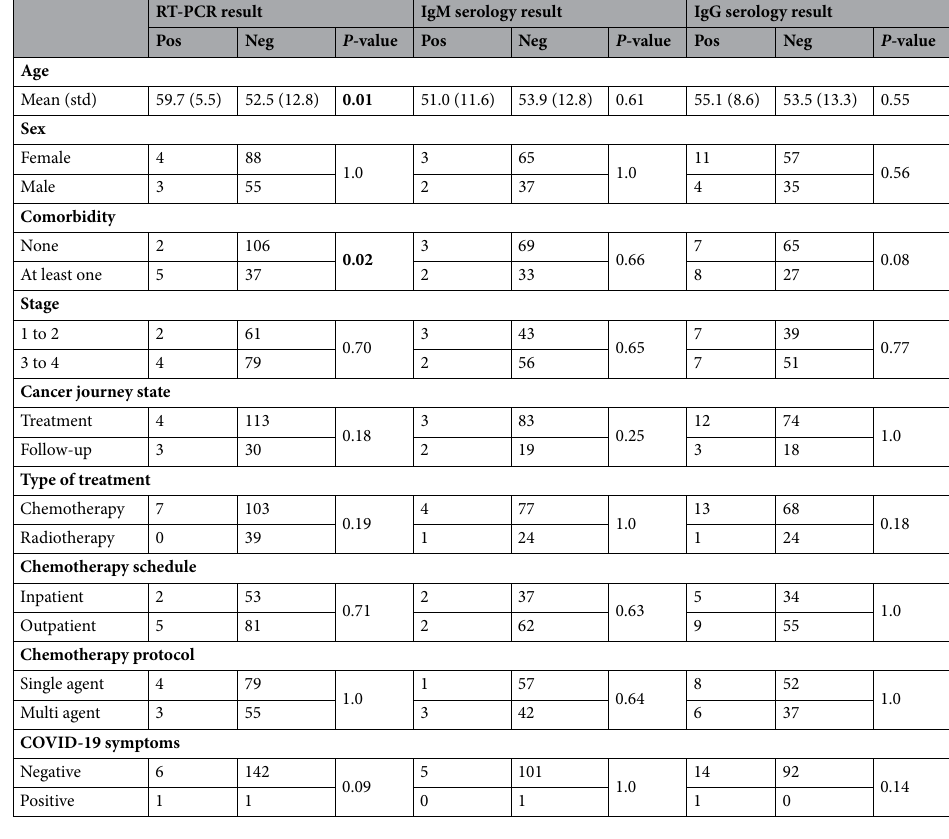
Table 1. Characteristics and outcome of 150 cancer patients tested for COVID-19. Significant values are in [bold].